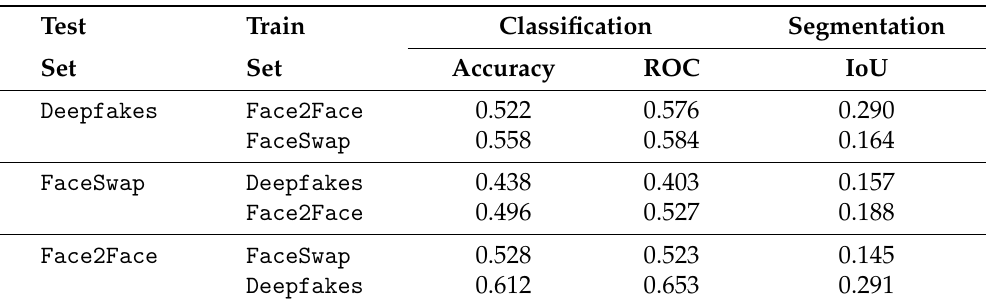
Table 7. Results for testing C23 crop images altered by the Deepfakes , Face2Face , and Face2Face manipulation methods with difference-based